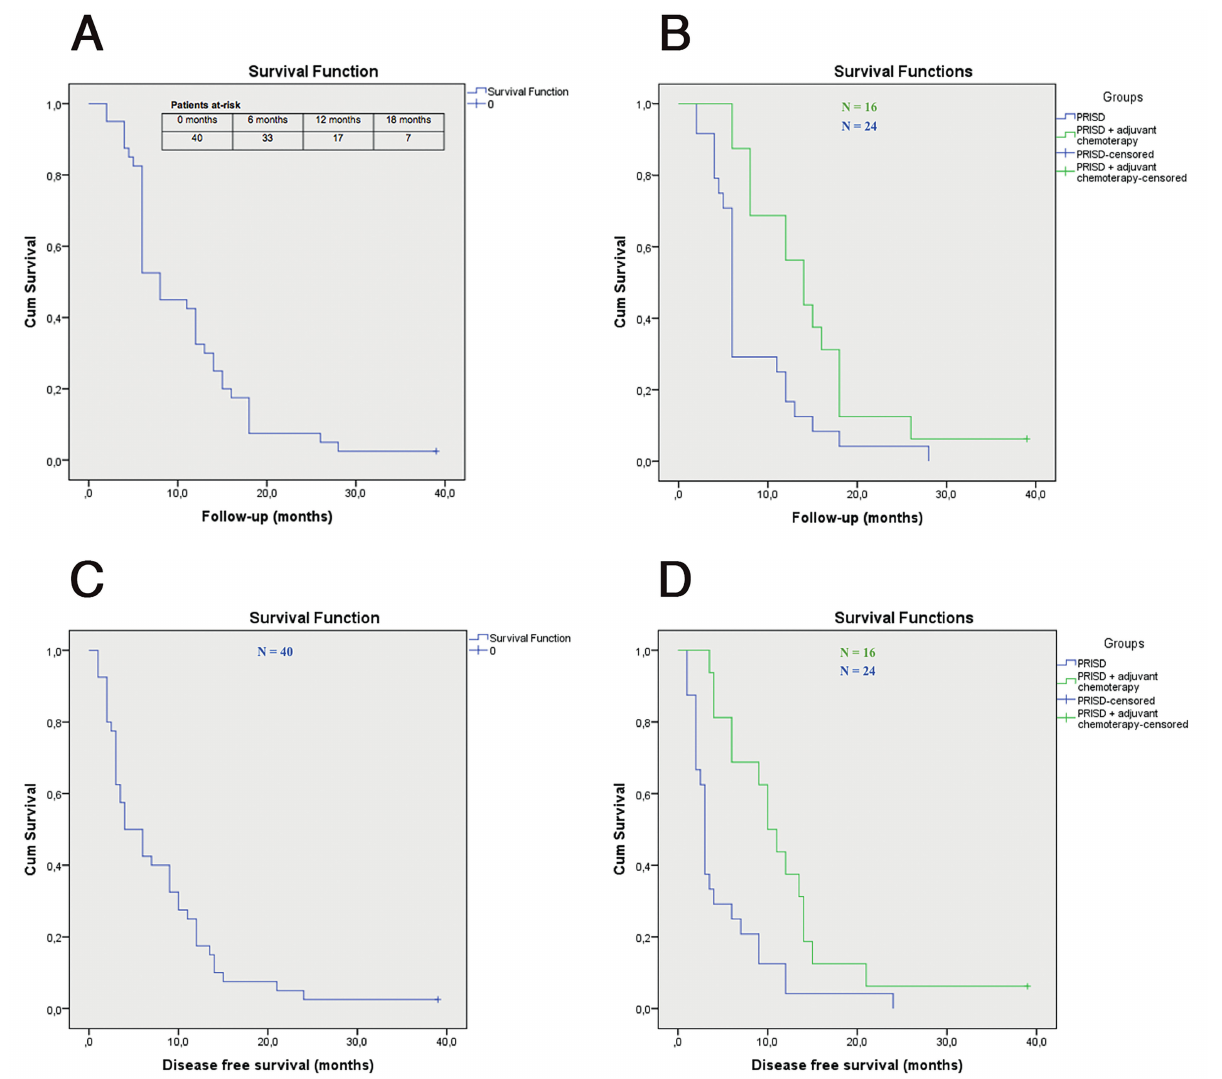
Figure 2 - A) Kaplan-Meier plots for overall disease-specific survival. B) disease-specific survival among patients submitted to primary radical inguinal surgical debulking (PRISD) alone against PRISD with adjuvant chemotherapy. C) overall disease-free survival and D) disease-free survival among patients submitted to PRISD alone against PRISD with adjuvant